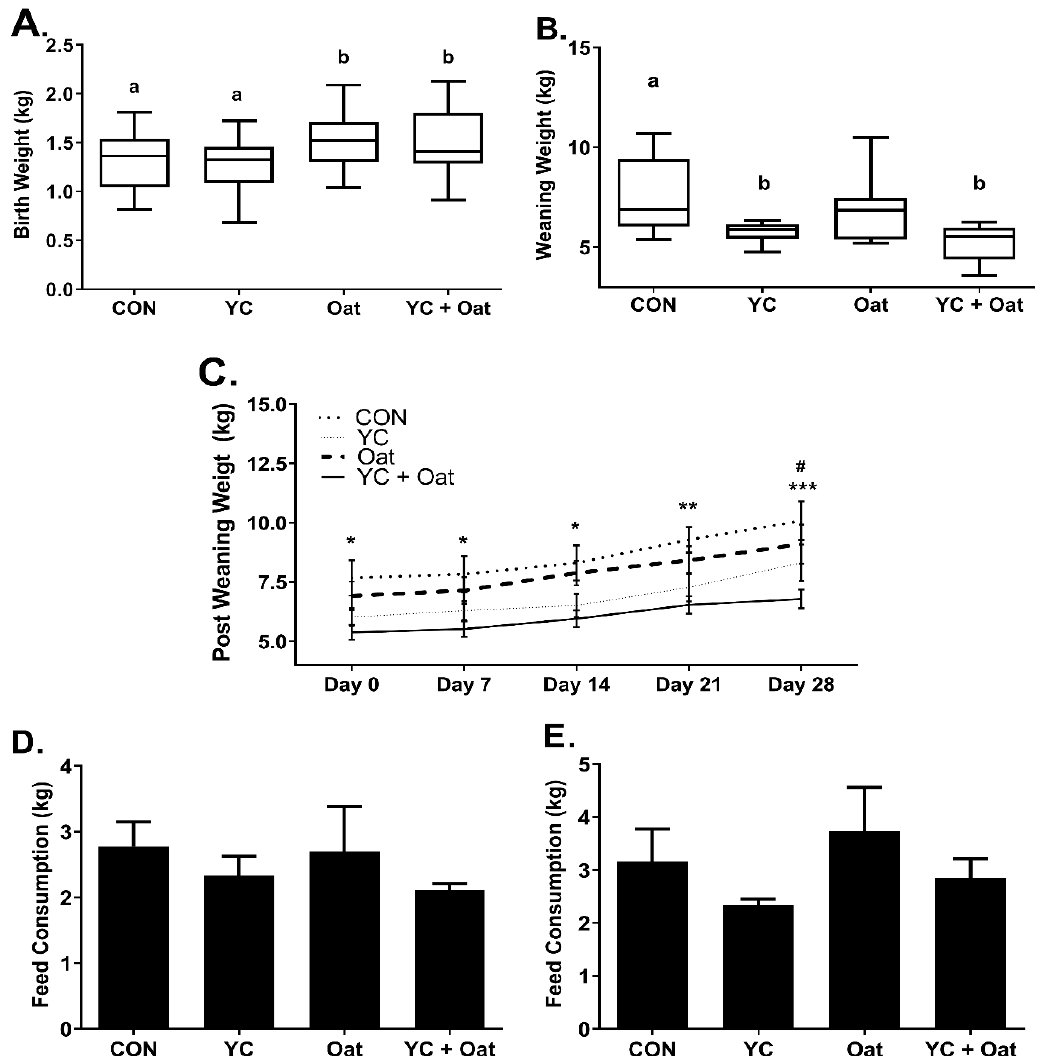
Figure 1. Piglet Weights and Post-Weaning Feed intake. Piglet weights ( n = 20) were taken on ( A ) day of birth and ( B ) day of weaning. a,b Different letters indicate a significant difference at p < 0.05. ( C ) Weights starting on day of weaning d0 and including days, 1, 7, 21, and 28 post-weaning. Data are an average of n = 10. Statistical difference between the CON and YC + Oat groups * p < 0.05, ** p < 0.01 *** p < 0.001. ( # ) Statistical difference between Oat and YC + Oat p < 0.05. Feed intake ( D ) for first week and ( E ) second week post-weaning. Data are an average of ( n = 4).